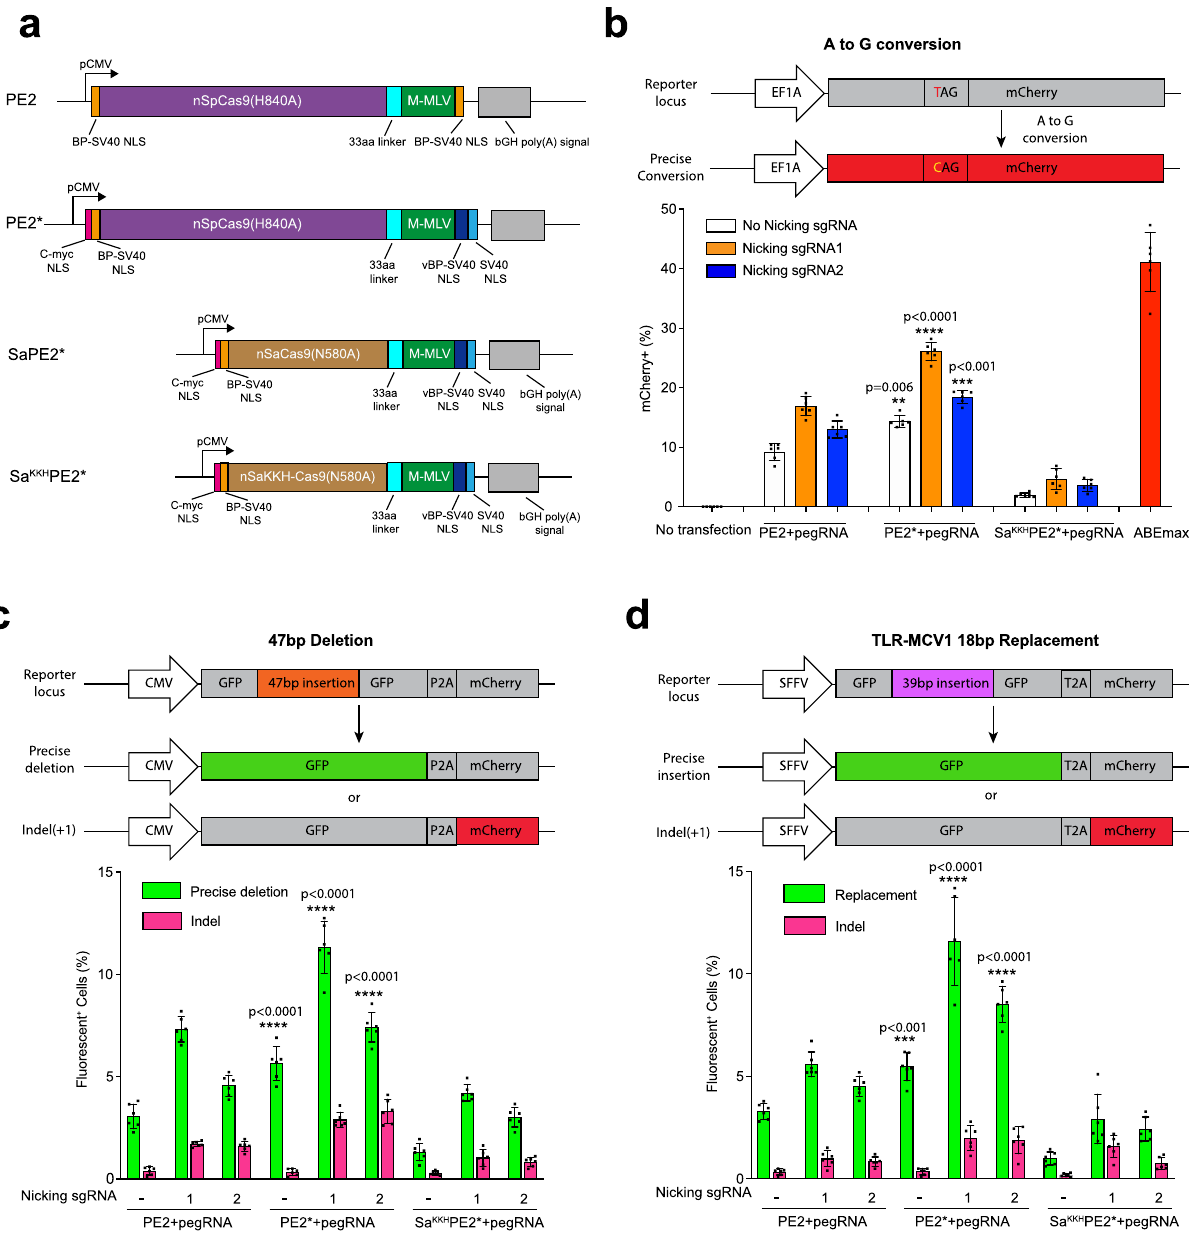
Fig. 1 Improved NLS composition enhances prime editing ef fi ciency. a Schematic representation of the original prime editor (PE2) and optimized prime editor (PE2*) carrying additional NLS sequences at the N-terminus and C-terminus. The M-MLV reverse transcriptase in PE2 was fused to a SaCas9 nickase (SaPE2*) or a SaCas9 KKH nickase (Sa KKH PE2*) with the same NLS composition to develop orthogonal prime editors. BP-SV40 NLS = bipartite SV40 NLS; vBP-SV40 NLS = variant BP-SV40 NLS. b Diagram of the A • T-to-G • C transition required to convert a stop codon to GLN to restore function to a mCherry reporter in HEK293T cells (top). Frequencies of targeted A • T-to-G • C transition by different prime editors (PE2, PE2*, and Sa KKH PE2*) were quanti fi ed by fl ow cytometry (bottom). c Diagram of the deletion reporter in HEK293T cells containing a broken GFP with 47-bp insertion, P2A, and out-of- frame mCherry (top). Targeted, precise deletion of 47 bp will restore GFP expression, whereas indels that create a particular reading frame alteration produce mCherry expression. Frequencies of precise deletion (GFP + ) and indel (mCherry + ) introduced by different prime editors (PE2, PE2*, and Sa KKH PE2*) were quanti fi ed by fl ow cytometry (bottom). d Diagram of the insertion reporter in HEK293 cells containing a broken GFP with 39-bp insertion, T2A, and mCherry (top). Targeted, precise insertion of 18 bp that substitutes for a disrupting sequence can restore GFP expression, whereas indels that create a particular reading frame alteration produce mCherry expression. Frequencies of targeted 18-bp replacement and indel generation by different prime editors (PE2, PE2*, and Sa KKH PE2*) were quanti fi ed by fl ow cytometry (bottom). All expression vectors were delivered by transient transfection. The presence of sgRNAs to promote nicking of the complementary strand is indicated in each fi gure legend. Results were obtained from six independent experiments and presented as mean ± SD. **P < 0.01, * **P < 0.001, * ***P < 0.0001 by one-way ANOVA with Tukey ’ s multiple comparisons test between each PE2 and PE2* using the same nicking sgRNA.